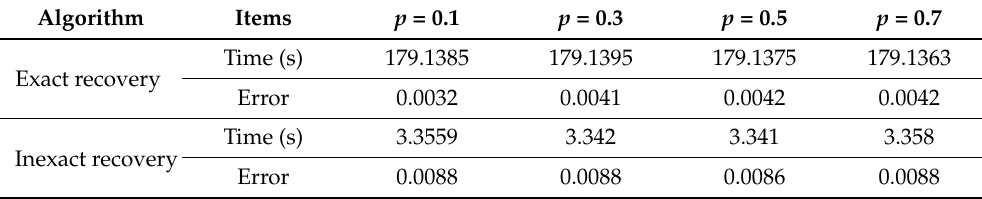
Table 4. Runtime and convergence error of both